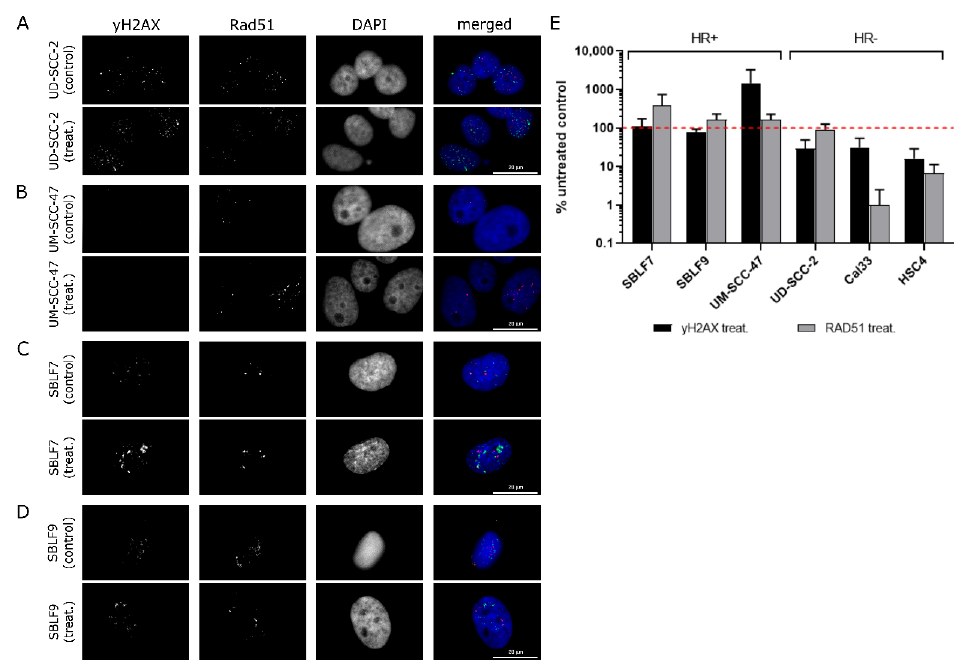
Figure 2. E ffi ciency of homologous recombination (HR) in two fibroblasts cell cultures, two human papilloma virus (HPV) + and two HPV- head and neck squamous cell carcinoma (HNSCC) cell lines. Cells were treated with DNA-PK inhibitor CC-115 to inhibit non-homologous end joining (NHEJ)